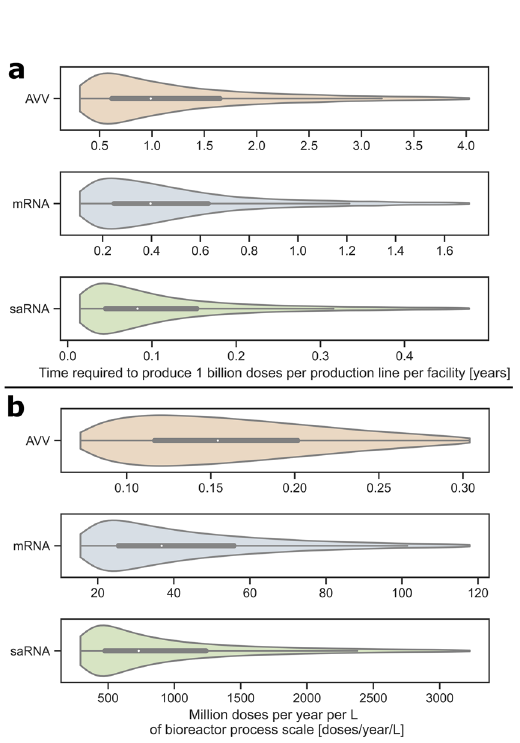
Fig. 3 Comparison of the AVV, mRNA and saRNA vaccine production platforms under the uncertainty scenarios in Table 1. a Violin plots of the required times for producing 1 billion doses of AVV, mRNA and saRNA vaccine drug substance. b Violin plots of the number of vaccine doses produced per year and unit bioreactor working volume. The box and whiskers inscribed within each violin plot depict the interquartile range and full percentile range (excluding outliers), respectively, and the median value is indicated by the white dot inside each box. The bottom 5% and top 5% of all values were excluded from all violin plots to enable a better visualisation of the region of interest around the box plot — cf. Supplementary Fig. 4 for violin plot comparisons on the same x -axis and including the full data